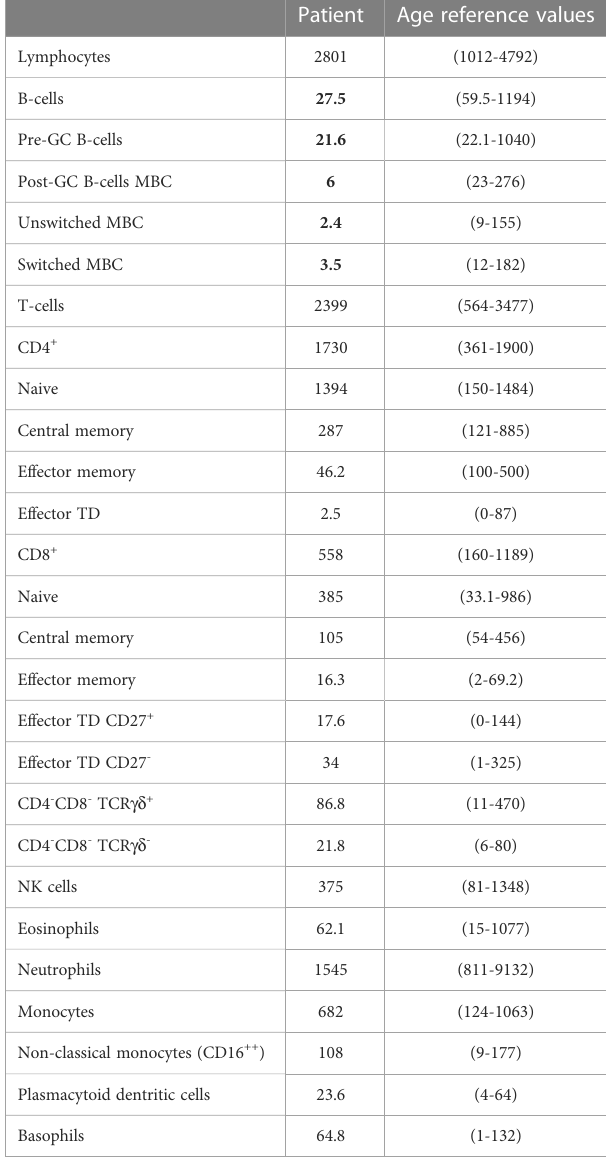
TABLE 1 Distribution of distinct peripheral populations analyzed with the EuroFlow Primary Immunode fi ciency Orientation Tube (PIDOT) vs. age-matched reference values.